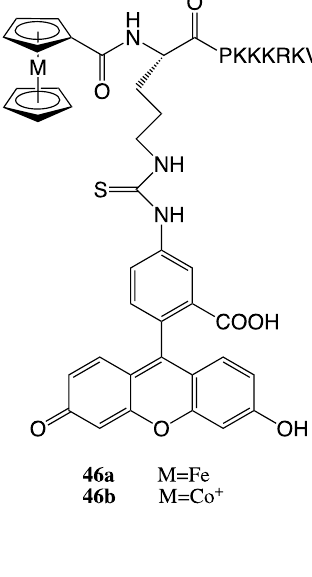
Figure 26. Structures of complexes 45 and 46a – b .